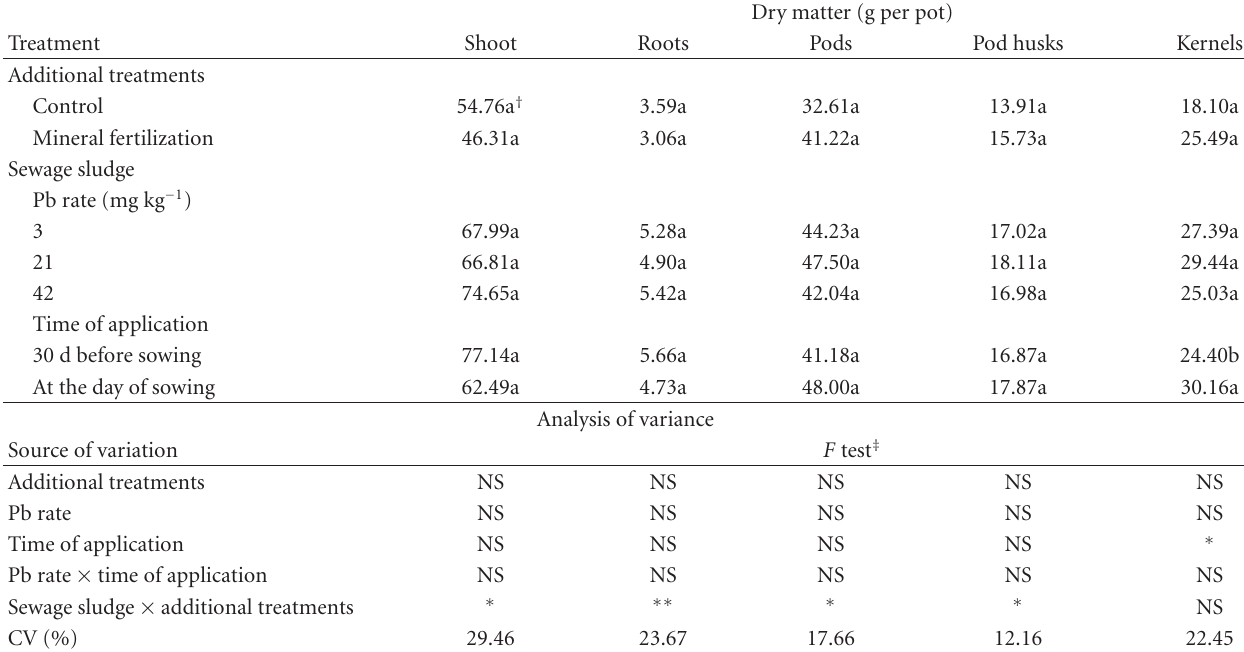
Dry matter (g per pot)